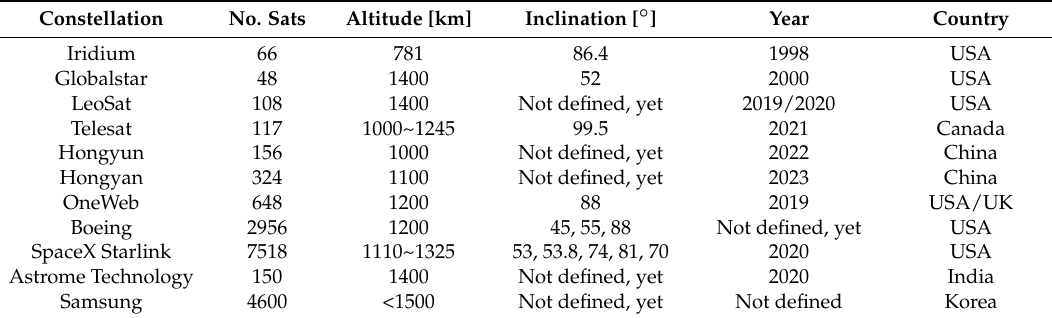
Table 1. The summary of some deployed or proposed commercial communication LEO constellations.